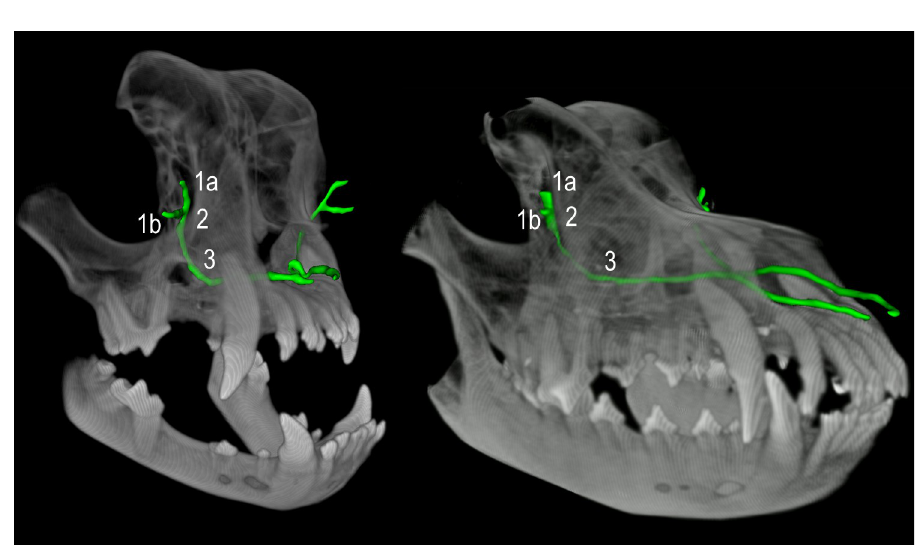
Fig 3. Comparative course of the nasolacrimal drainage system (NDS) in a brachy- and normocephalic dog. The NDS is illustrated three-dimensionally, in green color, inside the skull of an English Bulldog and a Rhodesian Ridgeback. In the English Bulldog, the lacrimal canaliculi and initial part of the nasolacrimal duct (NLD) are directed backwards, the lacrimal canaliculi have much larger dimensions than those in the normocephalic dog, and the NLD has to cross beneath the maxillary canine root to reach the nasal cavity. (1a) upper lacrimal canaliculi, (1b) lower lacrimal canaliculi, (2) lacrimal sac, (3) nasolacrimal duct.